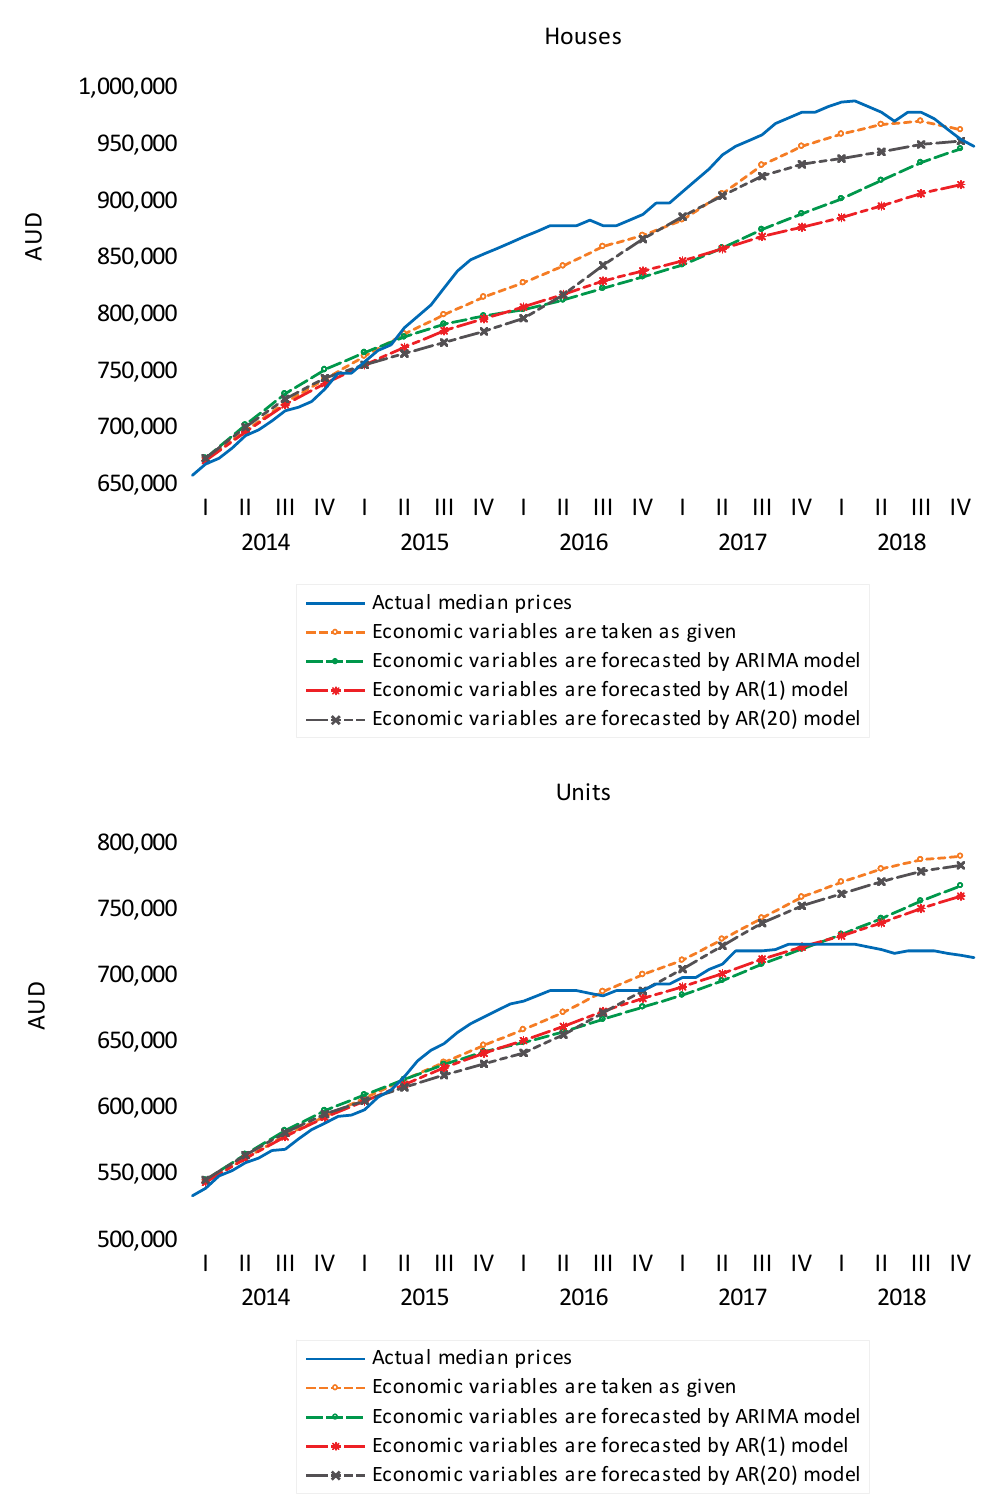
Figure 1. Out-of-Sample forecast, Q1 2014–Q4 2018. Panel B of Table 3 shows the results of conditional forecast when the underlying economic variables are unknown and must be forecasted. Two popular and widely-applied time-series forecasting techniques (ARIMA and AR models) were considered in this analysis. The results show that using an AR(1) process in the underlying economic variable forecast produced the best forecasting results for units, while an AR(20)